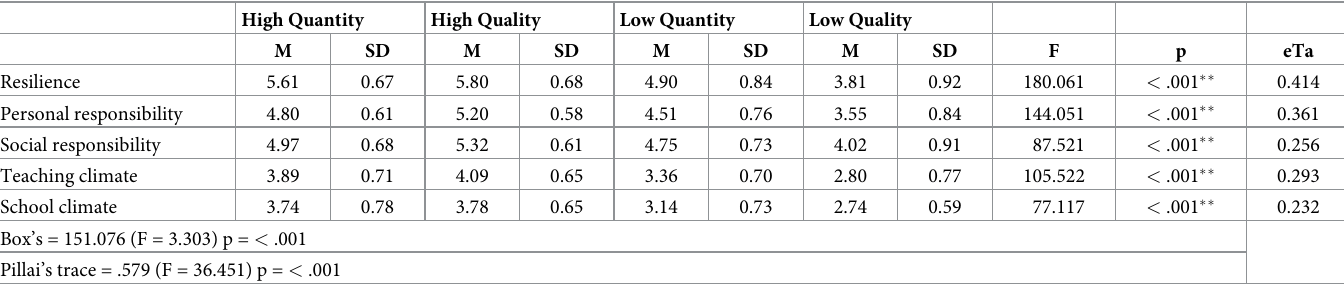
Table 3. Differences in resilience, responsibility and climate from motivational profiles.